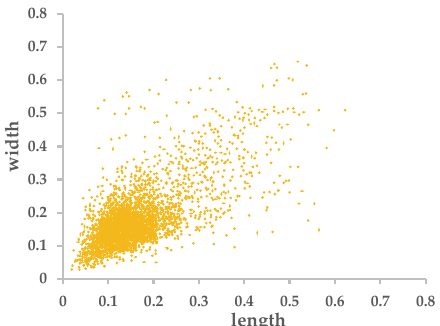
Figure 10. Proportion distribution of the size of objects.